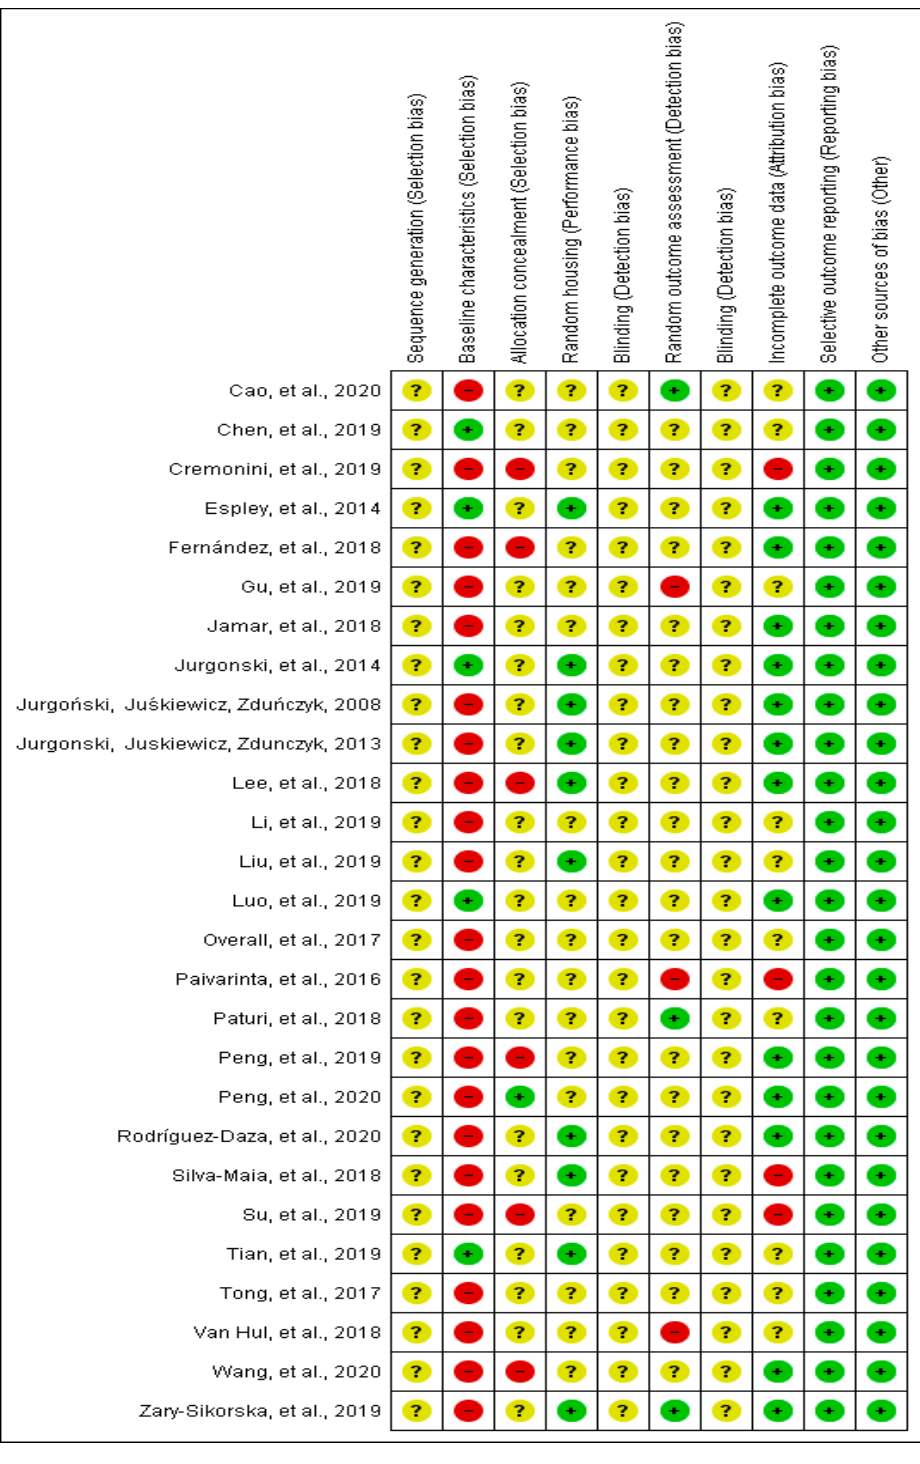
Figure 2. Risk of bias of animal studies.